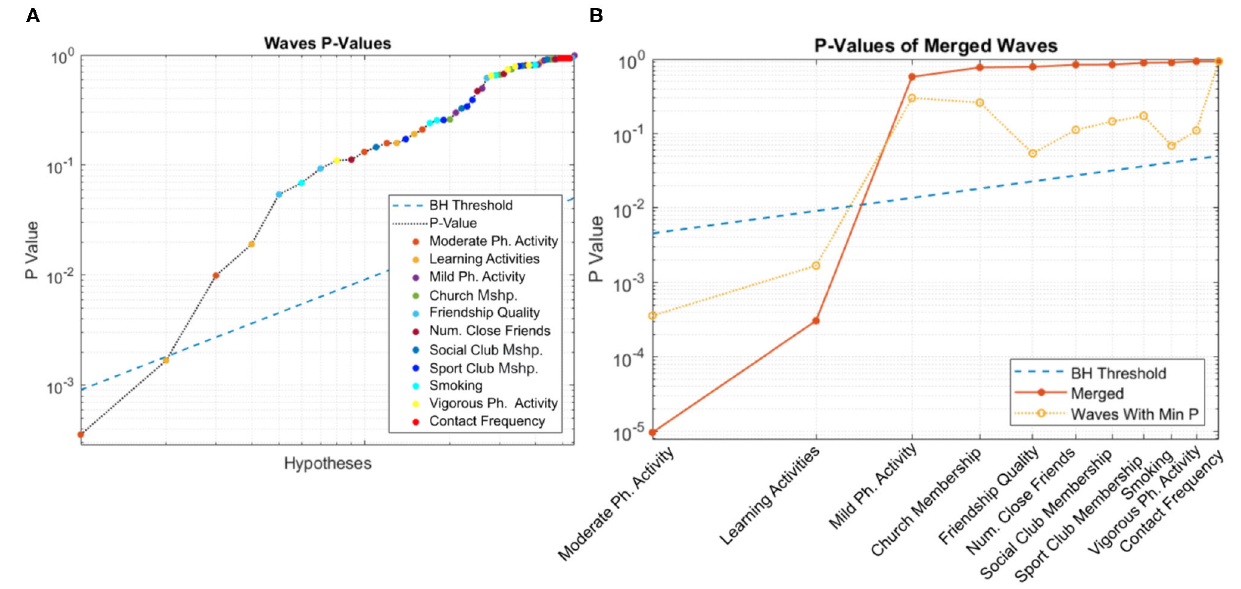
Frontiers in Aging Neuroscience |